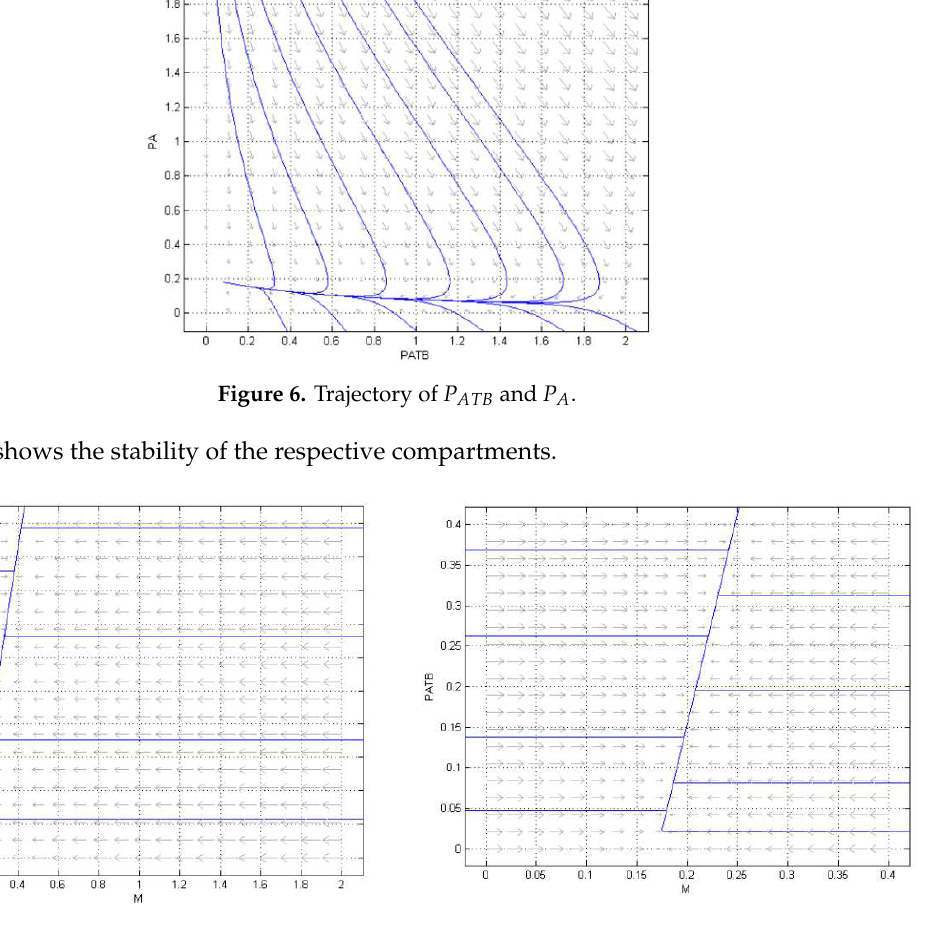
Figure 7. phase transition plot of M with